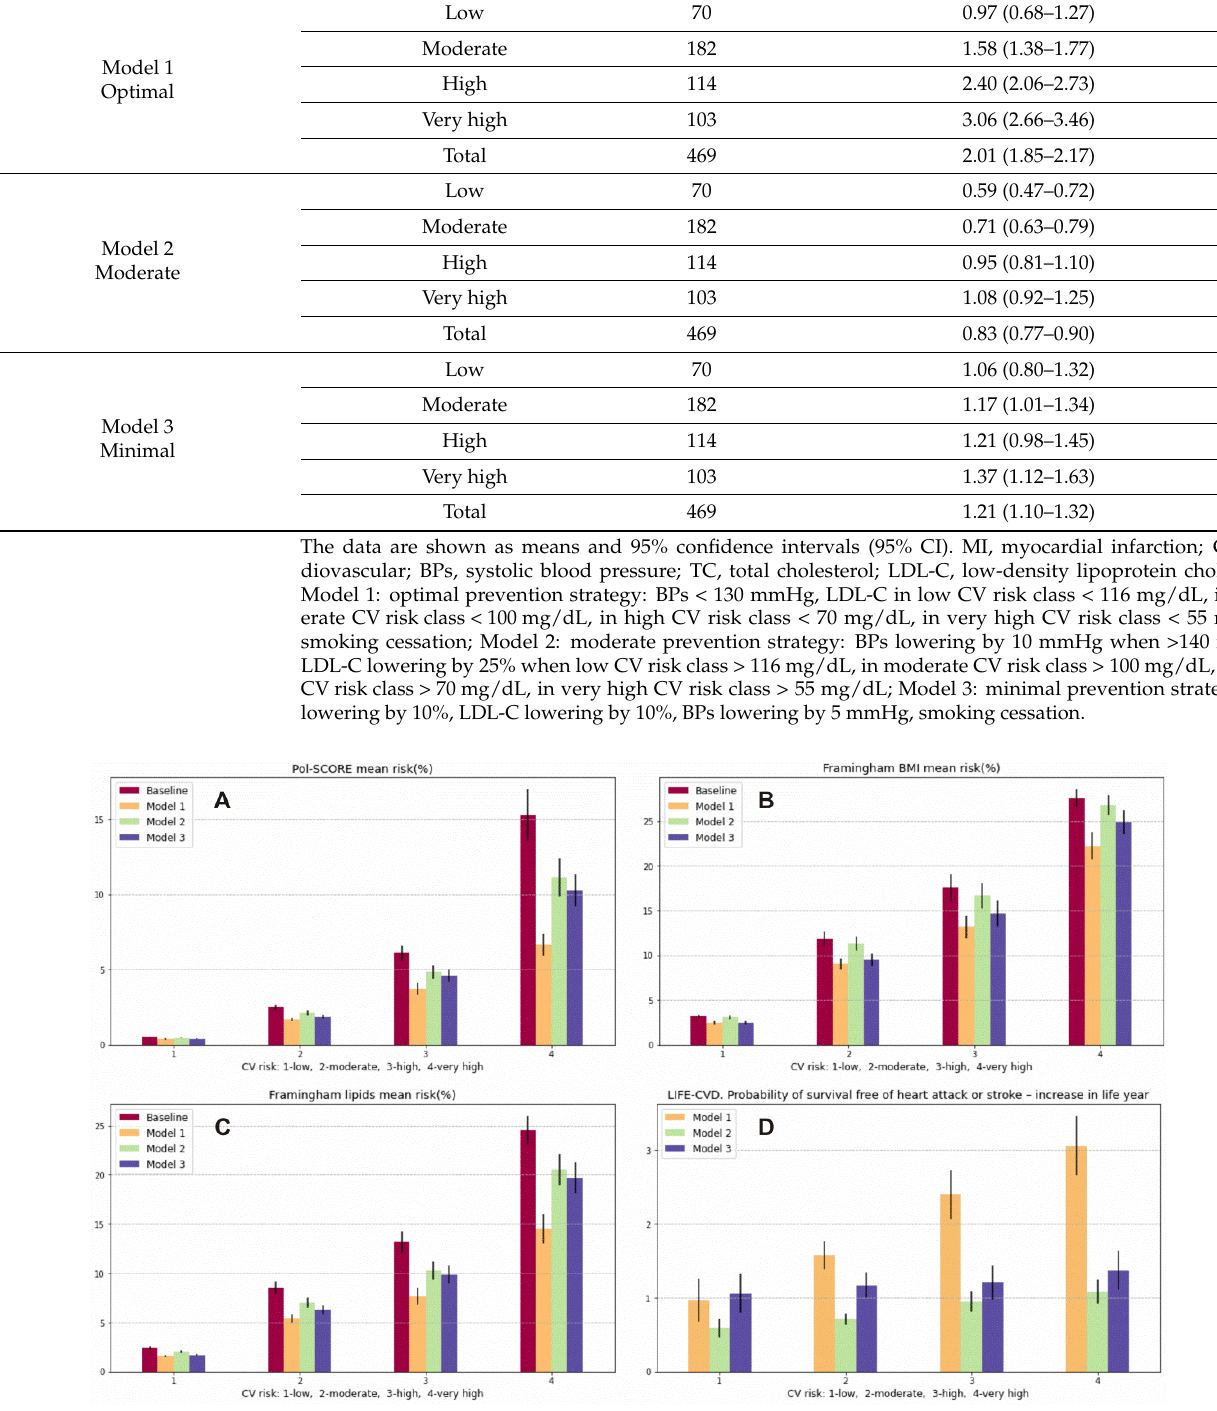
Figure 3. Prediction of 10-year risk of fatal CVD (Pol-SCORE): ( A ), prediction of 10-year risk of developing a first CVD event (Framingham Cardiovascular Disease) using the lipid model ( B ) and the BMI model; ( C ), probability of survival-free heart attack or stroke—increase in life years (LIFE-CVD) ( D ). Variables are presented as means and 95% confidence interval (95% CI). In Table 5, we present the estimated number of the local inhabitants who would survive (Pol-SCORE) or who would not develop their first CVD event within 10 years (FRS) and would not develop MI, stroke, or CV death (LIFE-CVD) within 10 years or within their lifetime after applying the appropriate prevention strategies. Finally, in Ta- ble 6, we present the estimated CVD burden in the local population based on an earlier analysis [8]. We performed this analysis in order to be able to present these data to rep- resentatives of the authorities and the community more vividly. We want to emphasize the number of local people with improperly treated or unrecognized CV risk factors who, without the proper preventive programs, will develop complications or die from CVD. Table 5. Estimated number of local the inhabitants who would survive (Pol-SCORE) or who would not develop a first CVD event within 10 years (Cardiovascular Disease Framingham Heart Study) or who would not develop MI, stroke, or CV death (lifetime-perspective model for individualizing cardiovascular disease prevention strategies in apparently healthy people LIFE-CVD) within 10 years or within their lifetime after applying prevention strategies. SCORES